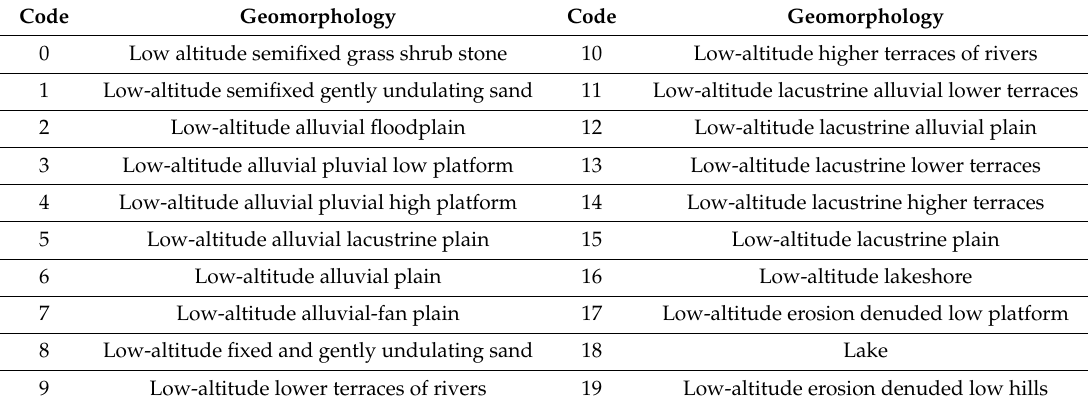
Table A1. Type of geomorphology.